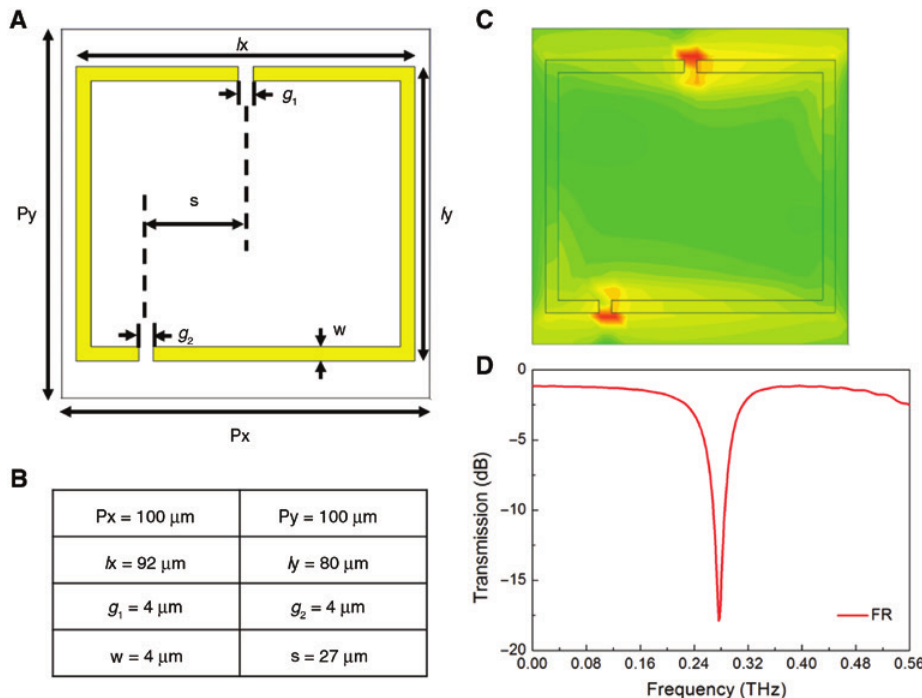
Appendix-Figure 1: Simulation detail of FR: (A) 2D structure model, (B) structural parameters, (C) electrical field distribution, and (D) transmission spectrum.